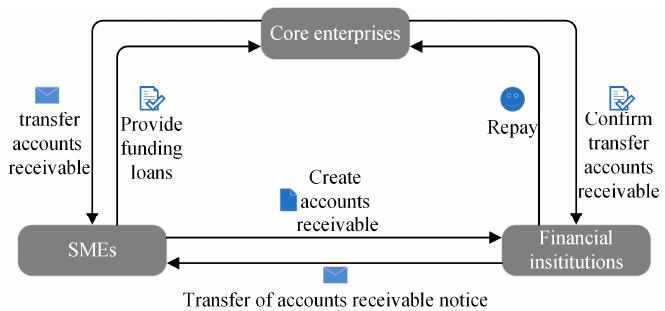
Figure 2. Accounts receivable financing.